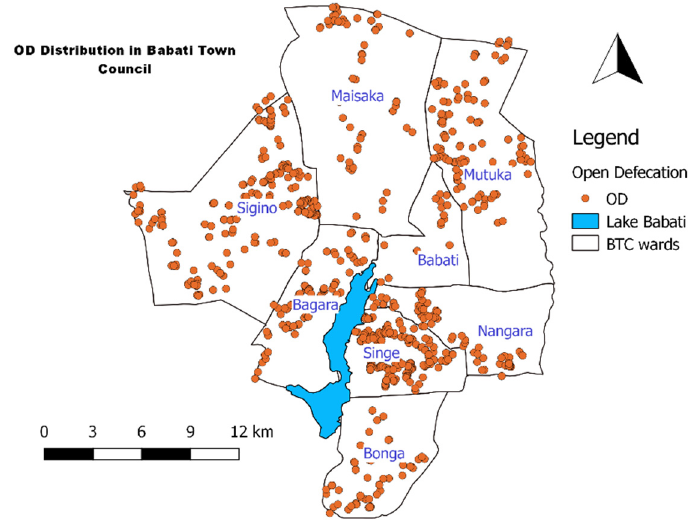
Figure 3. Distribution of households practicing open defecation in Babati Town.